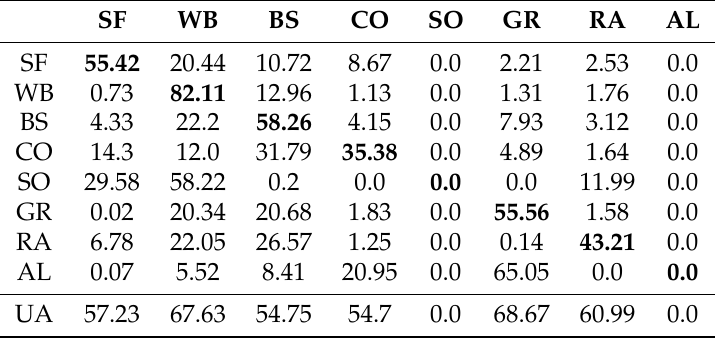
Table 6. Confusion matrix for 29-01-2015 using Sentinel-1 alone (3 images). κ = 0.49.